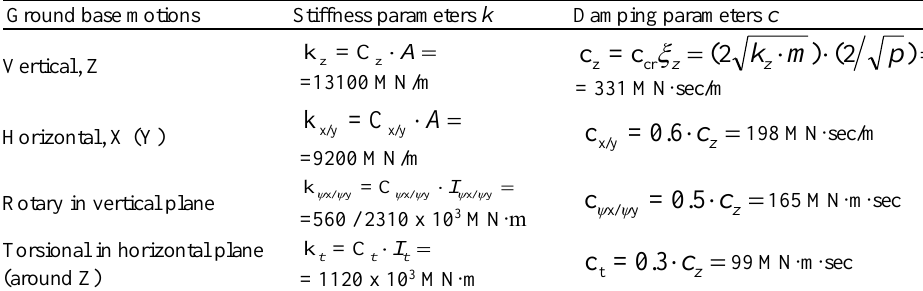
Table 2. Design Code SP 26.13330.2012 parameters for soil-structure interaction